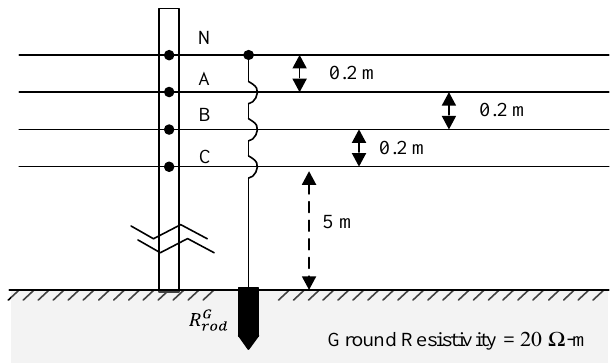
Figure A1. The wiring configuration for phase-A, -B, -C, and -N together with grounding re- sistance.